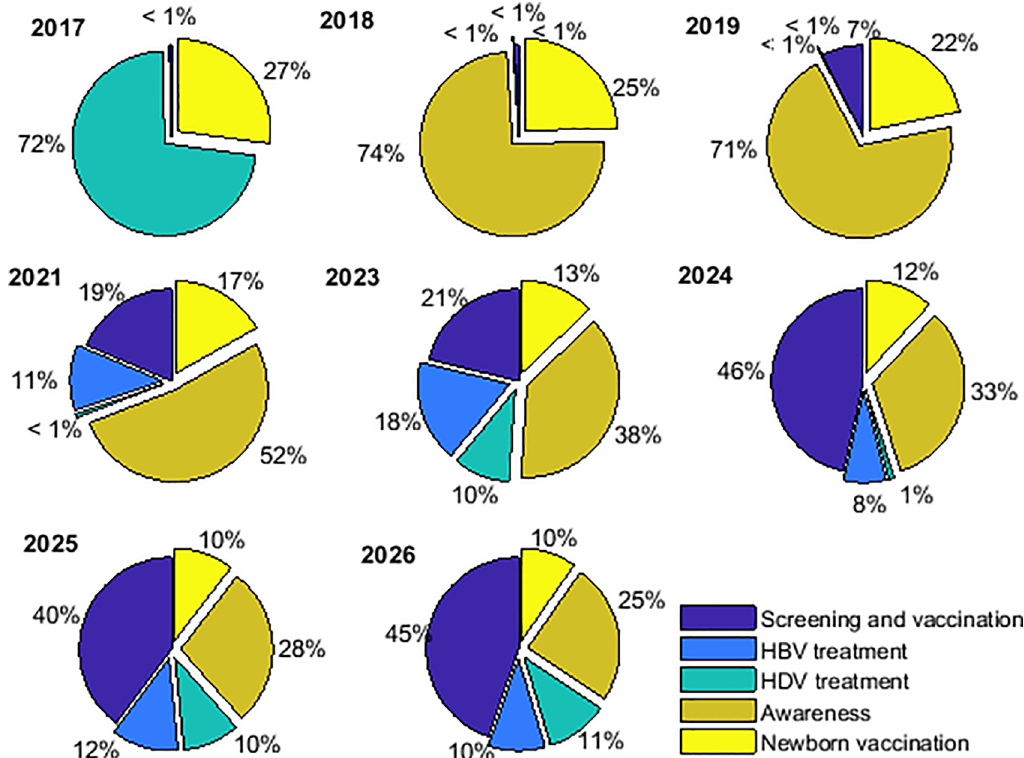
Fig 3. Illustration of the dynamic allocation of the budget among five interventions under strategy 4 in Brazil between 2017 and 2027.